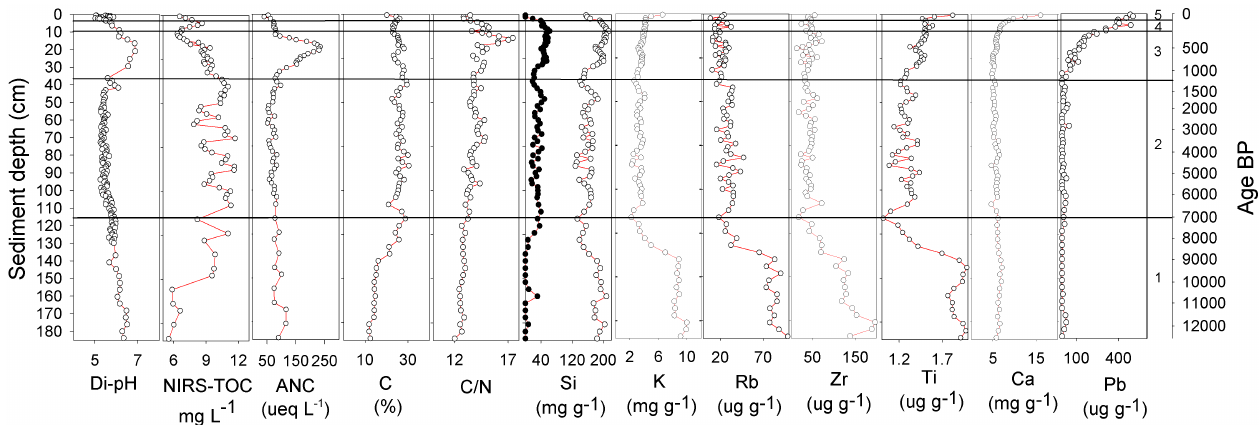
Fig. 2. Records of diatom-inferred lake water pH (Di-pH), lake-water total organic carbon inferred from near infrared spectroscopy (NIRS- TOC), modeled ANC and sediment content of organic carbon (C), ratio of organic carbon to nitrogen (C/N), total silica (Si) (open circles) along with biogenic silica (BSi) (filled circles), potassium (K), rubidium (Rb), zirconium (Zr), titanium (Ti), calcium (Ca) and lead (Pb) along the Holocene sediment core from Lake Lysevatten. Five different periods are indicated (1) early lake ontogeny with large changes in the proxy data, ca. 12500–7000 BP; (2) a stabilization phase, ca. 7000–1100 BP; (3) an early anthropogenic disturbance and